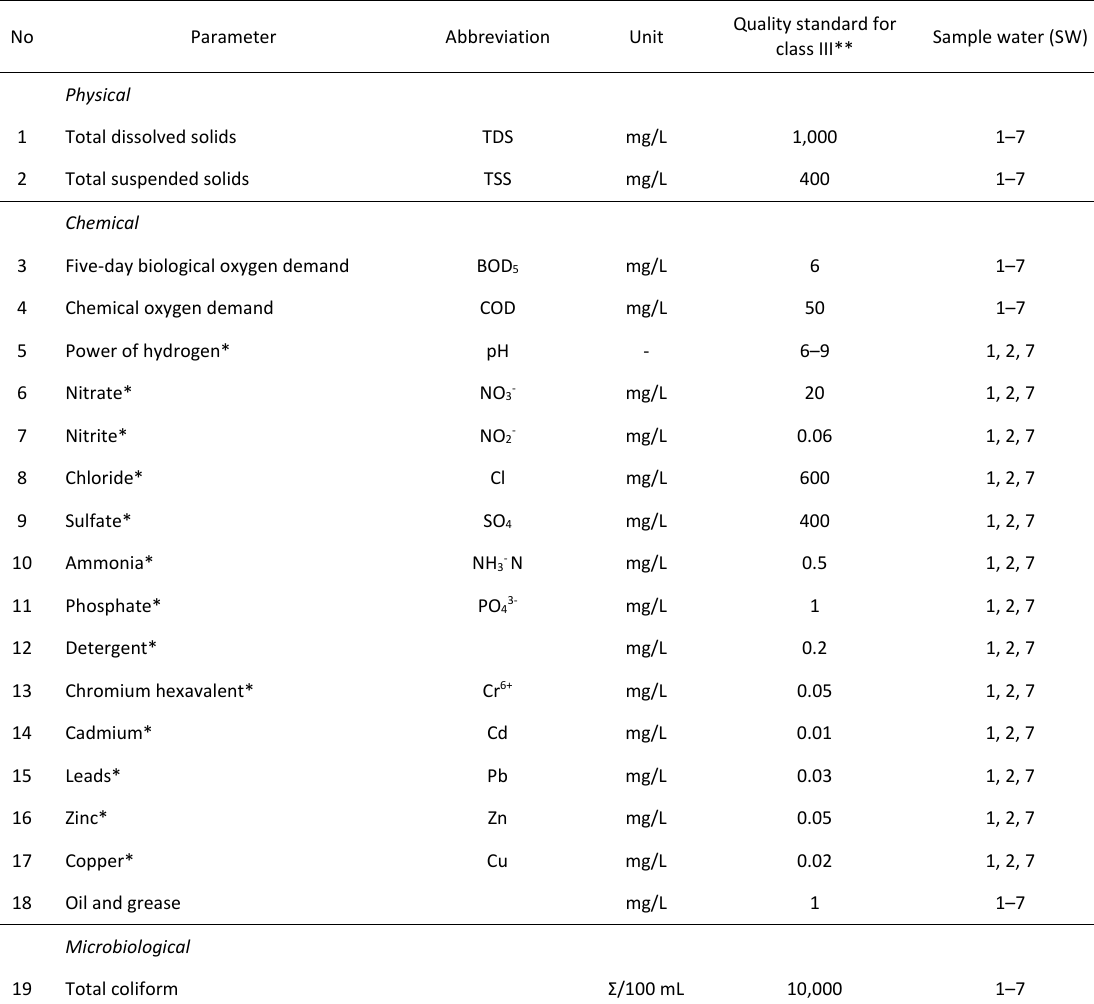
Table 2: Test parameters and their maximum allowable presence (MLHK, 2016)